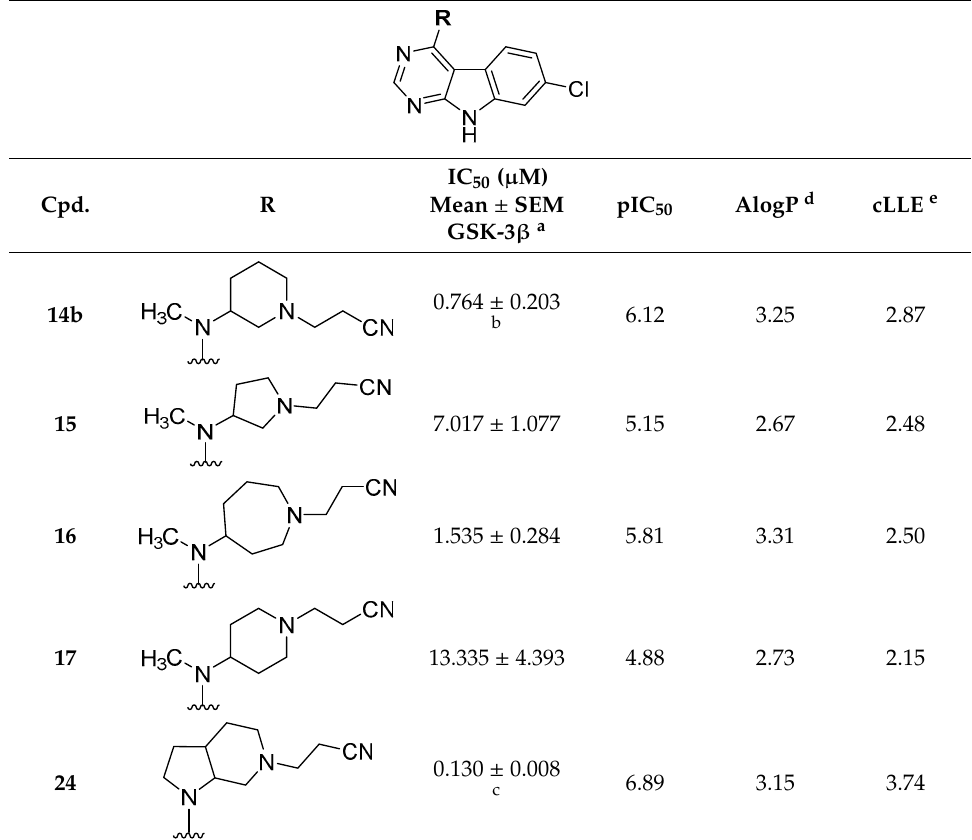
Table 2. Structures, biological activity and AlogP-derived lipophilic ligand efficiencies (cLLE) of compounds 14b , 15 – 17 and 24 .